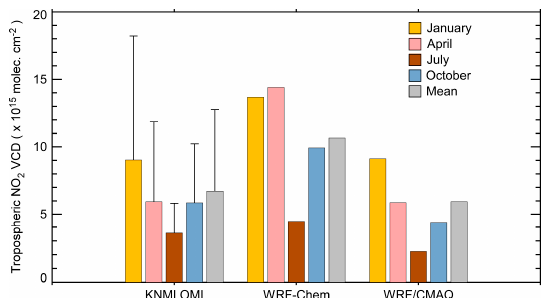
Figure 4. The spatial distributions of tropospheric NO 2 VCD over the South Korean region averaged for a period of January, April, July, and October 2015. (a) KNMI OMI NO 2 VCD, (b) WRF-Chem modeled NO 2 VCD, and (c) WRF/CMAQ modeled NO 2 VCD.